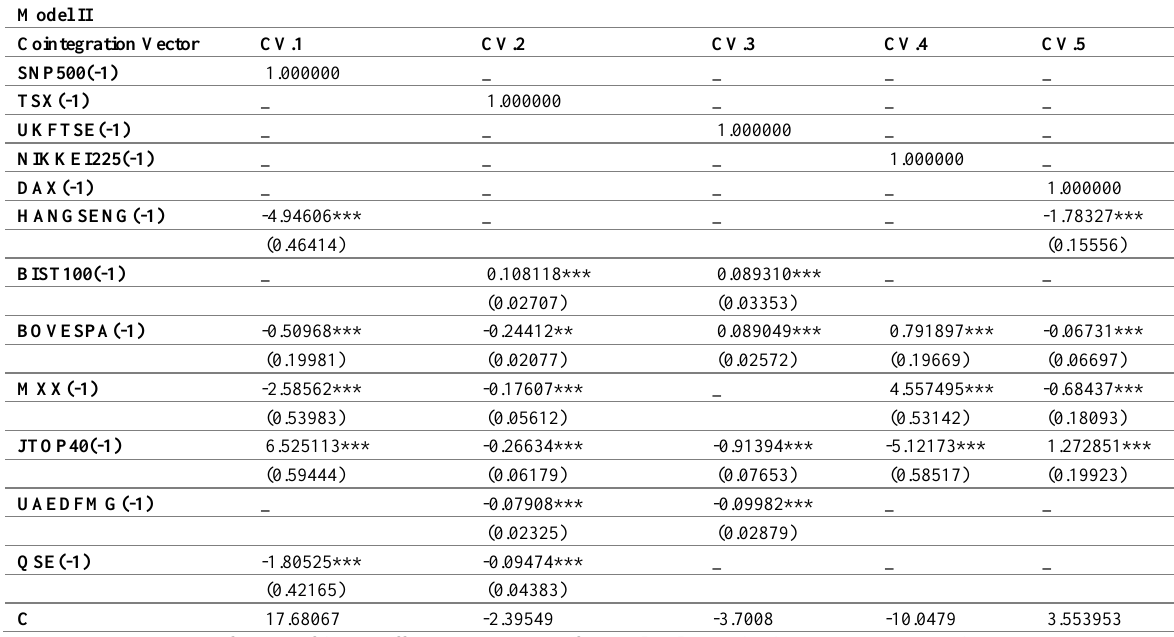
Table 7: Normalized Cointegration Coefficients